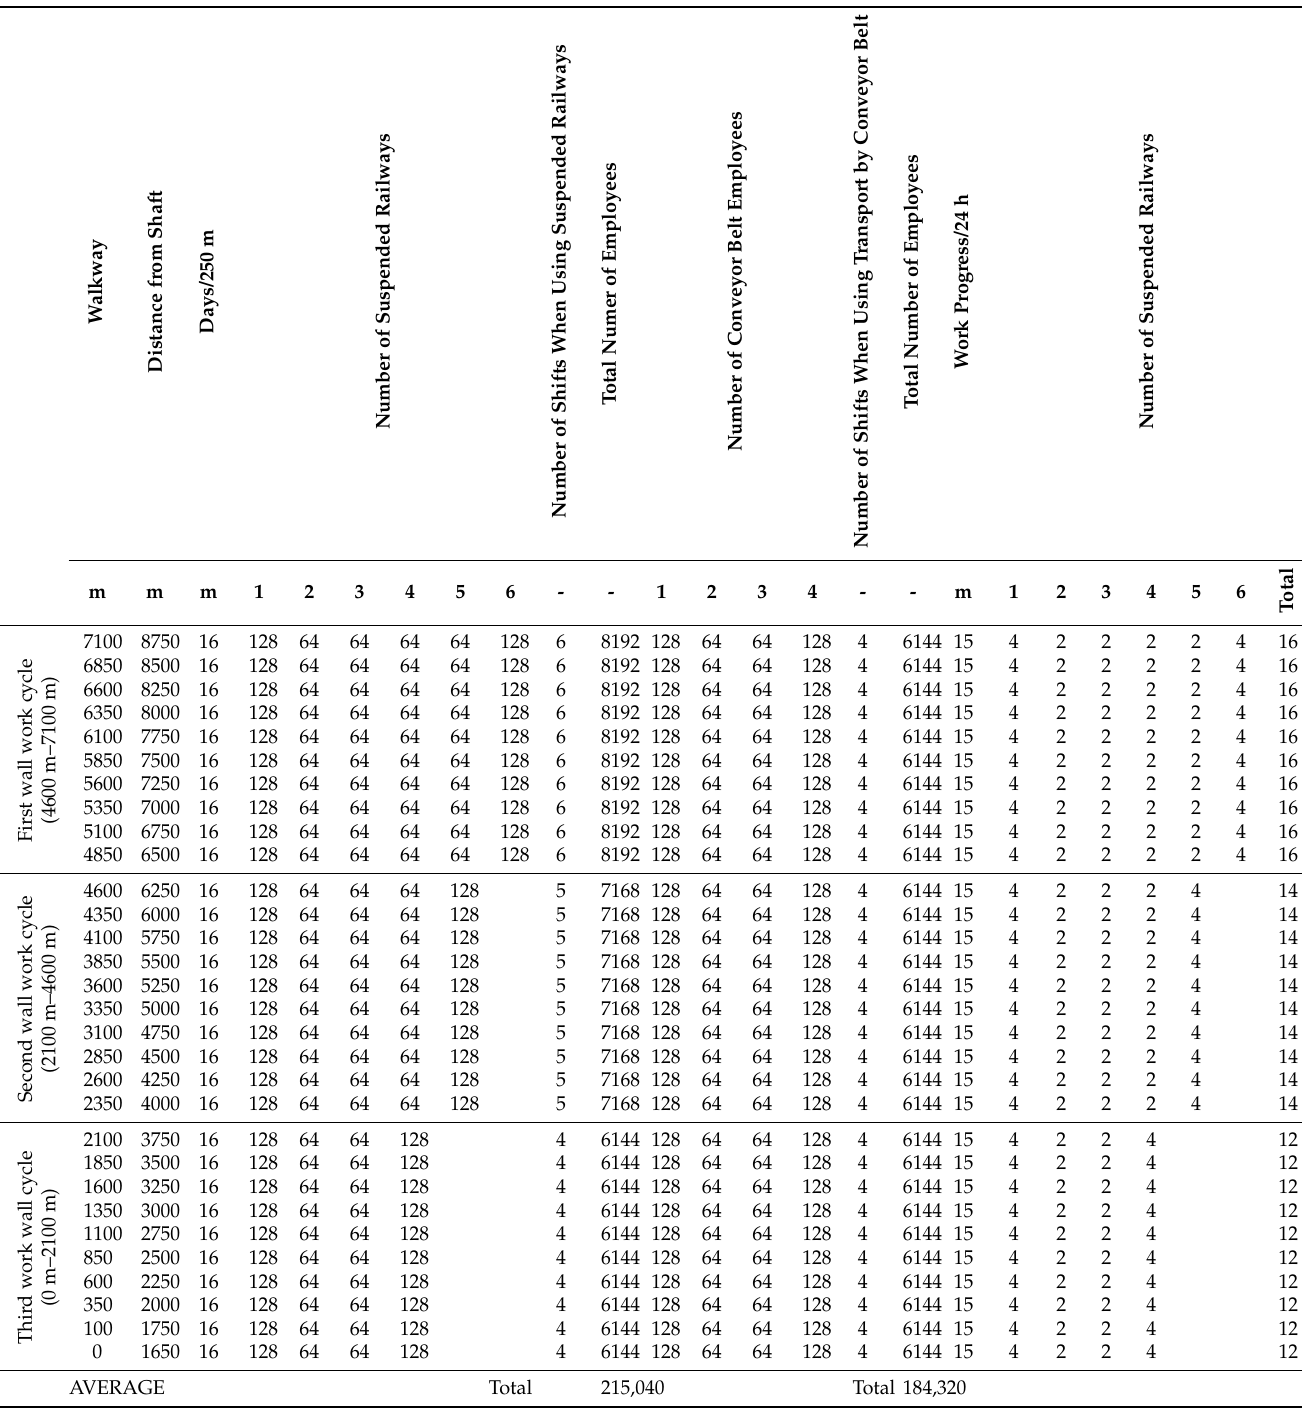
Table 5. Summary of work progress, crew size, and rolling stock of suspended